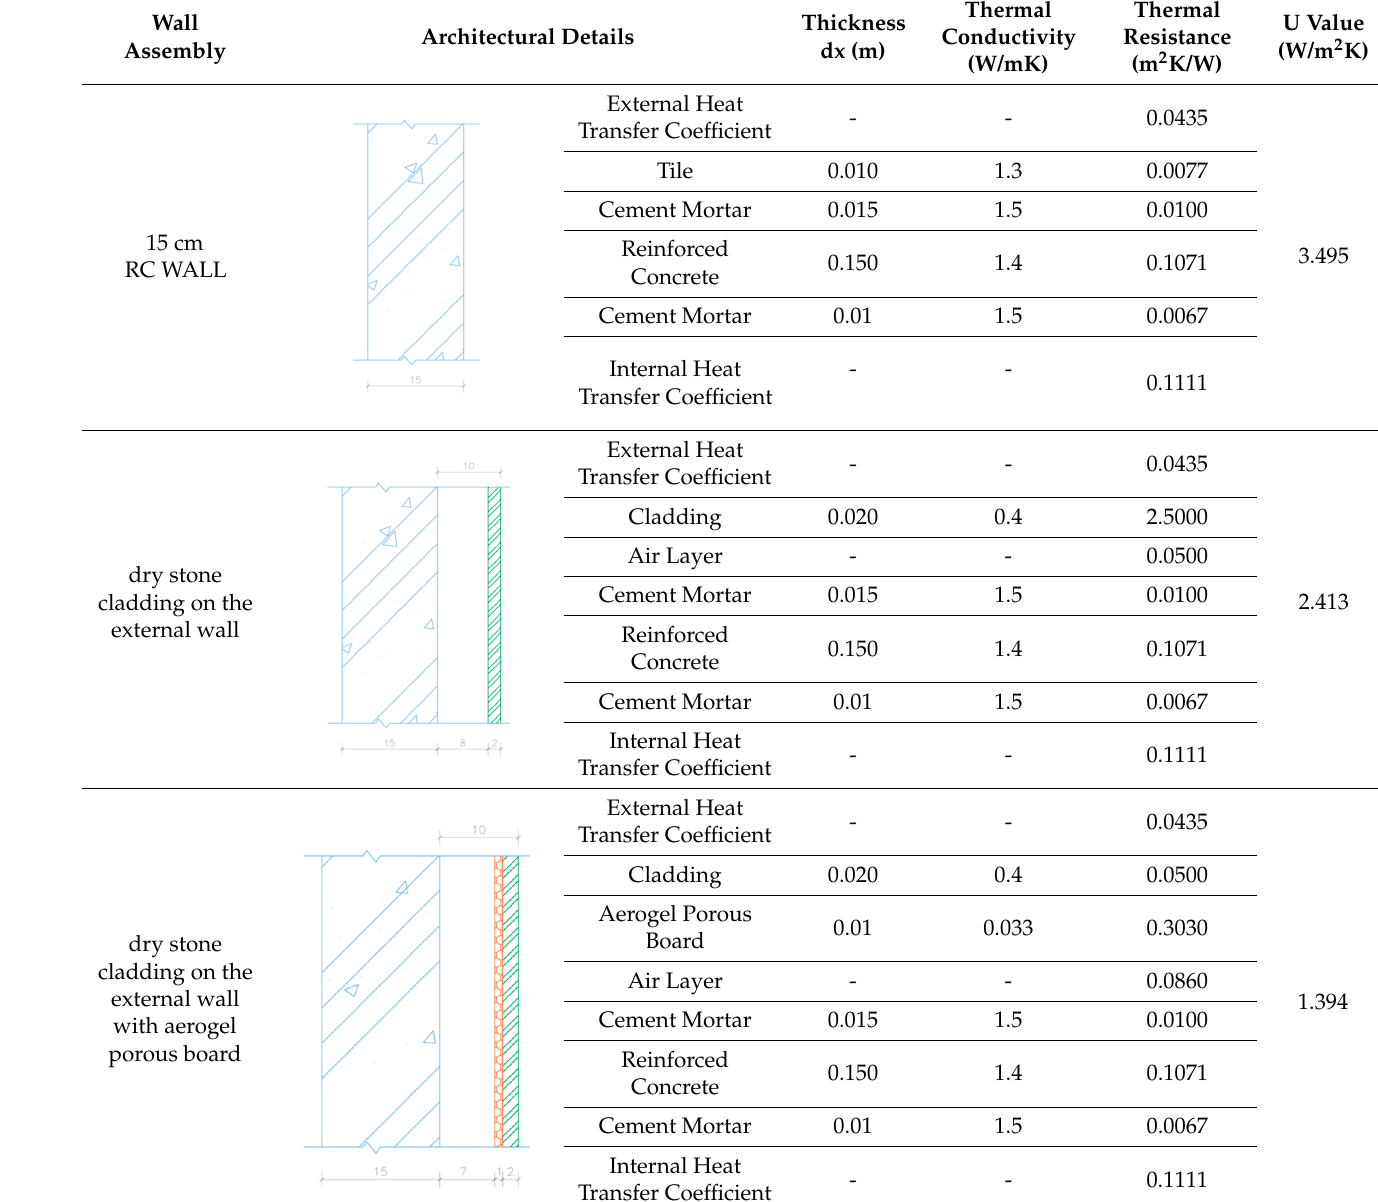
Table 4. The U value of the building wall system.